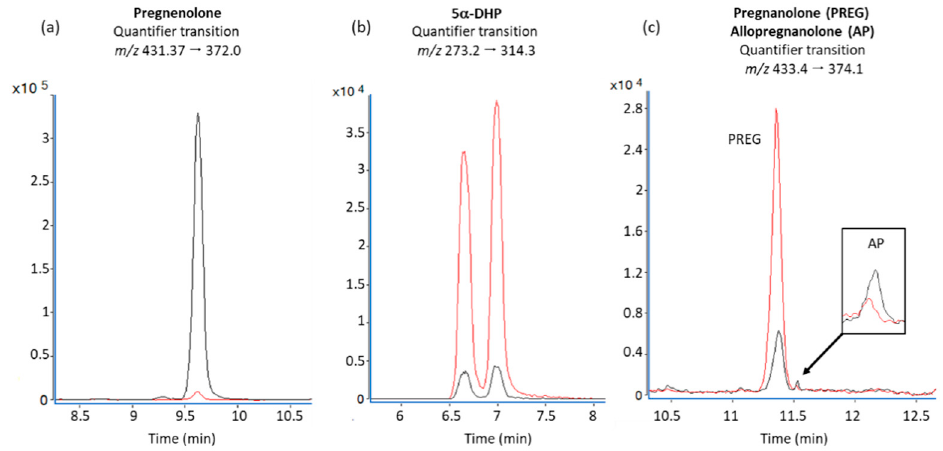
Figure 3. MRM quantifier transition for ( a ) pregnenolone, ( b ) 5 α -DHP, ( c ) pregnanolone and allopregnanolone as found in the medium of BV-2 cells at the 72 h time interval (black traces: resting cells; red traces: cells activated by rotenone).